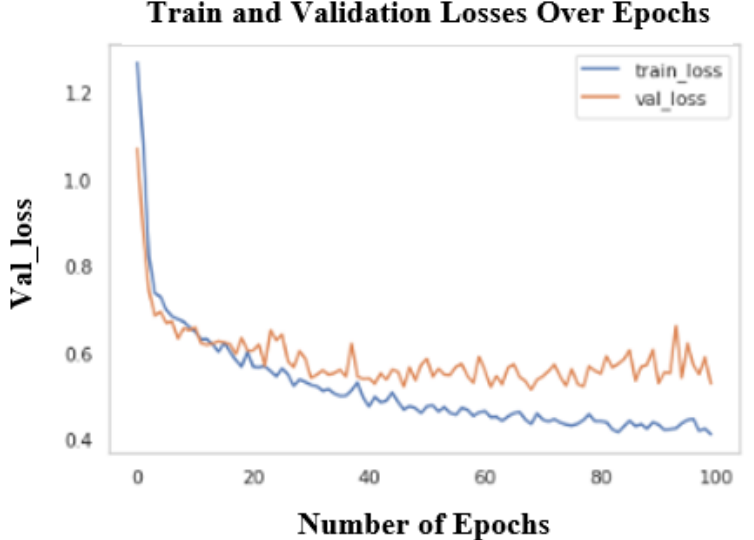
Figure 9. Validation accuracy.